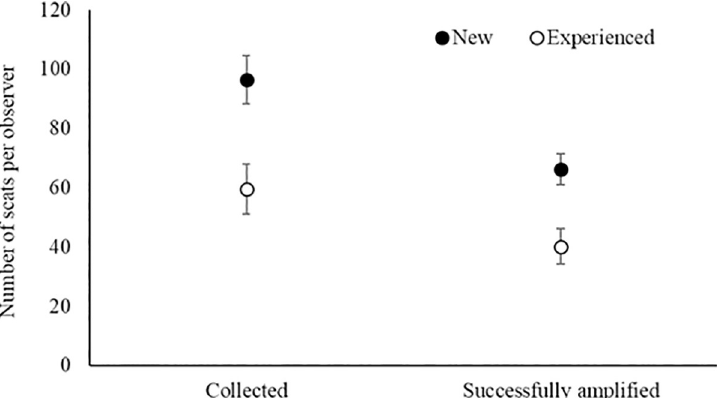
Fig 1. Number of fecal samples collected and successfully amplified as a function of observer experience level (n = 58), during genetic surveys for wolves in Alberta, Canada, central Idaho, and Yellowstone National Park, WY, USA, 2008–2014. Error bars represent the